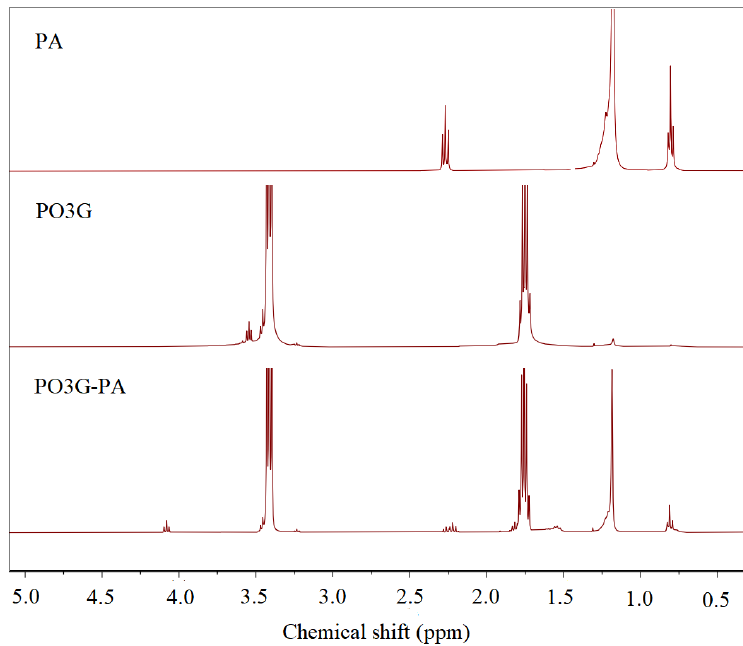
Figure 2. 1H NMR hydrogen spectra of PA, PO3G and PO3G–PA.